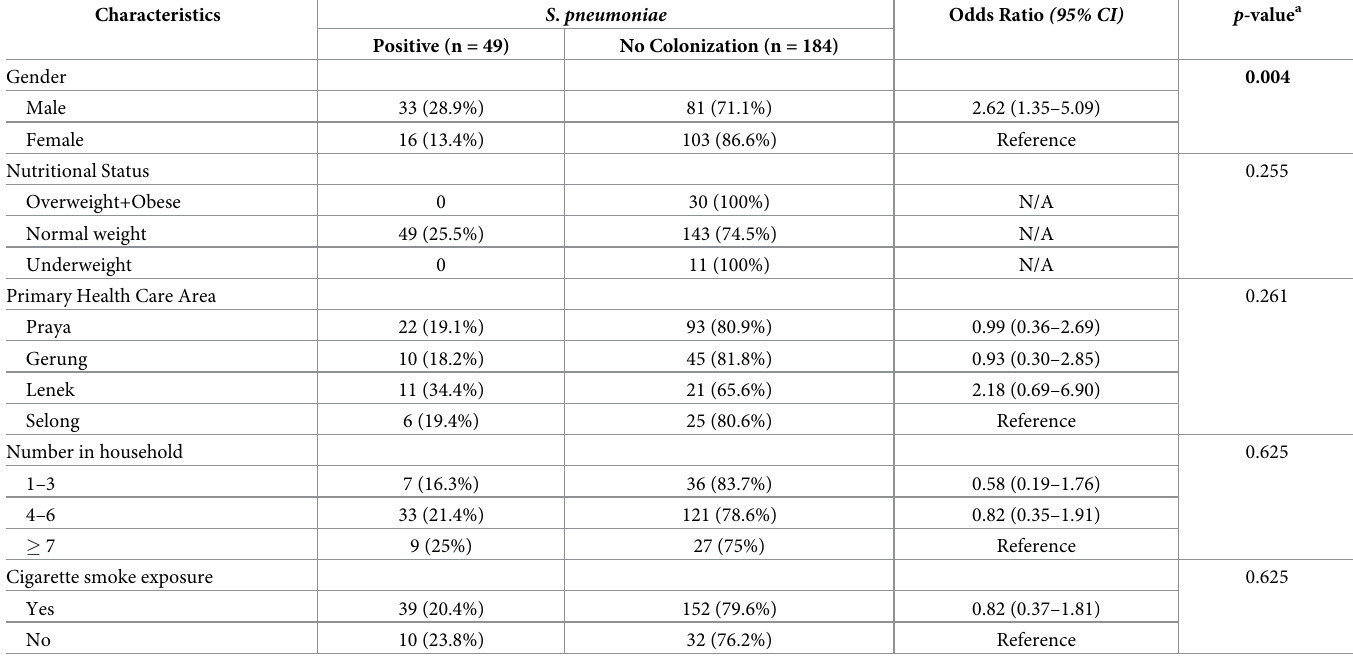
Table 2. Demographic characteristics in S . pneumoniae positive and negative groups.